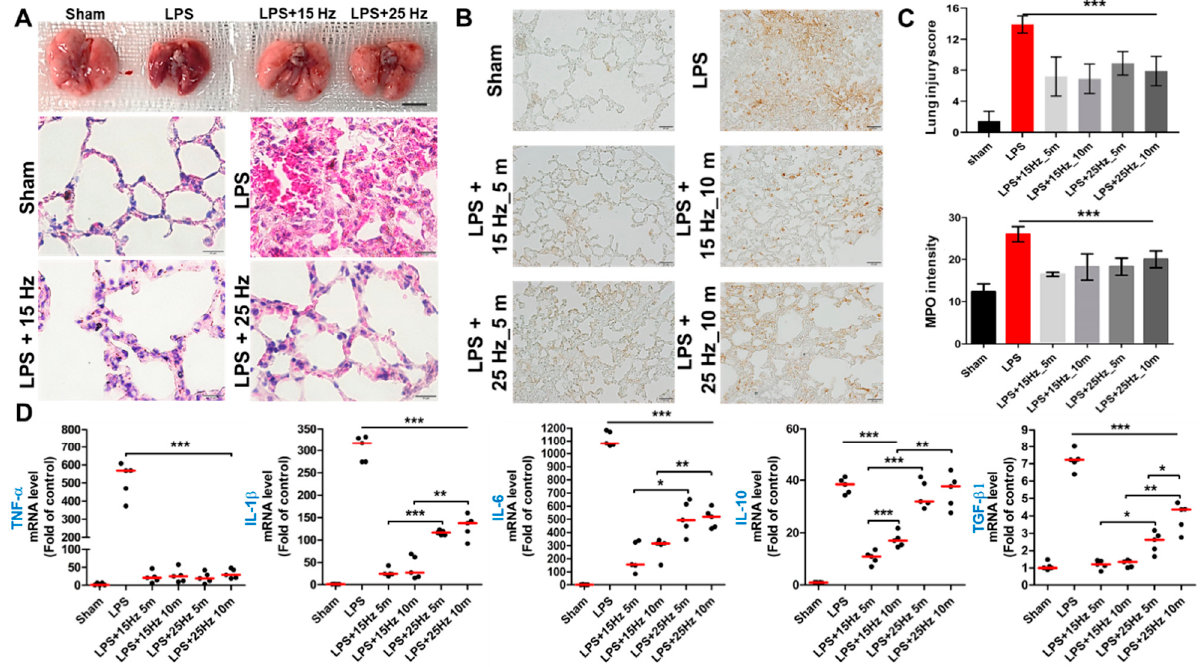
Figure 4. Anti-inflammatory effect of taVNS on the lung of LPS-induced endotoxemia. ( A ) The representative images of the lung after treatment of taVNS with 15 Hz and 25 Hz. Scale bar: 5 mm. The results of H&E staining were determined using the lung injury score upon observation under a light microscope. Scale bar: 10 μ m. ( B ) MPO staining was determined by the infiltrated immune cells on the lung. Scale bar: 20 μ m. ( C ) The relative scoring of lung injuries was compared as a graph in three independent images. Positively stained area was measured in three different images in each group and then represented on a graph. ( D ) The expression levels of pro- and anti-inflammatory cytokines genes were determined by qPCR, and significance was compared among groups. Data have been presented as the means and standard deviation (n = 5–10); * p < 0.05, ** p < 0.01, and *** p < 0.001, as compared to the corresponding control.